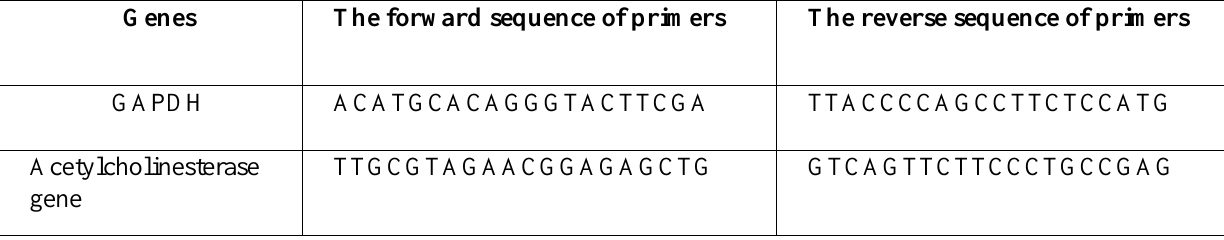
Table1. Primer sequences of